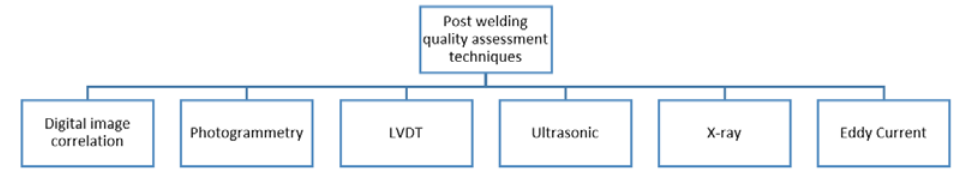
Figure 3. Quality assessment post-welding